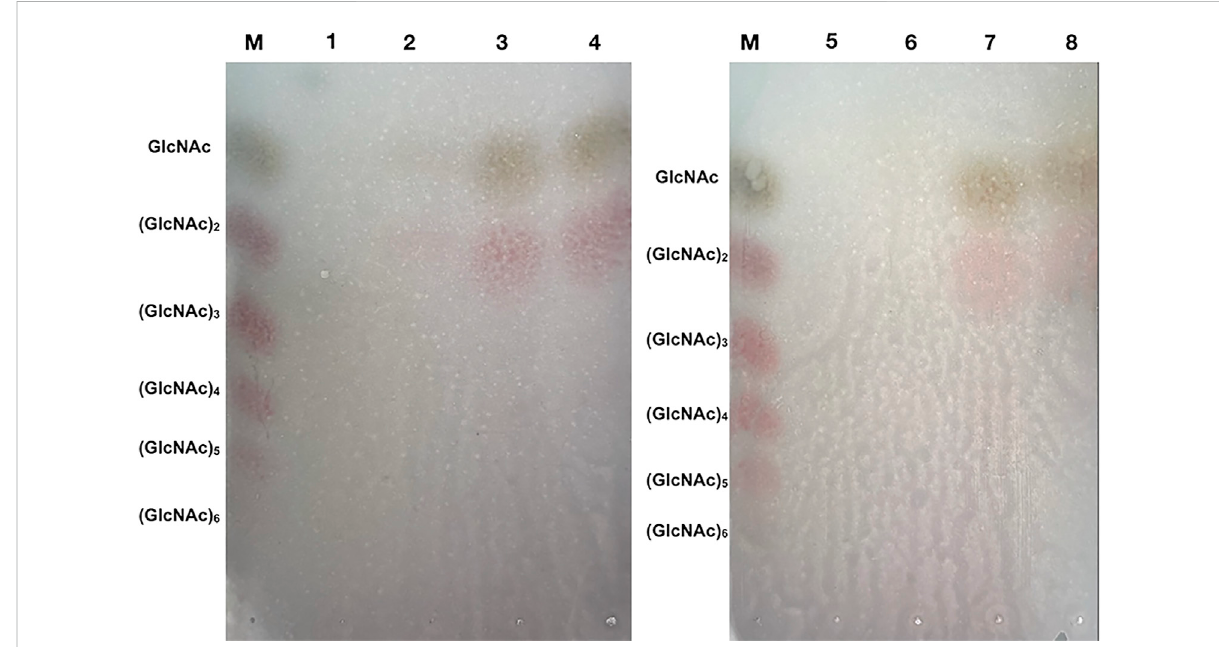
FIGURE 7 TLC analysis of the degradation products of Δ 30 Af ChiJ. M, Standards of chitin oligosaccharides with degrees of polymerization between 1 and 6; 1 and 5, The degradation products of inactivation Δ 30 Af ChiJ was used to be control; 2 – 4, The degradation products of Δ 30 Af ChiJ with colloidal chitin for 2, 4, and 8 h; 6 – 8, The degradation products of Δ 30 Af ChiJ with colloidal chitin for 1, 3, and 6 h. Developing solvent: n-butanol, acetic acid and aqueous (2:1:1). Color reagents: 1 g diphenylamine, 1 ml aniline, 5 ml 85% phosphoric acid, and 50 ml